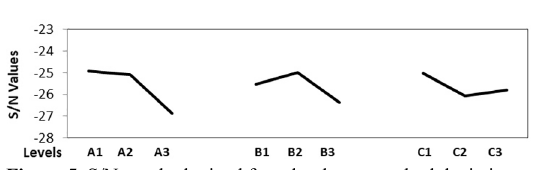
Figure 5. S/N graph obtained from hardness standard